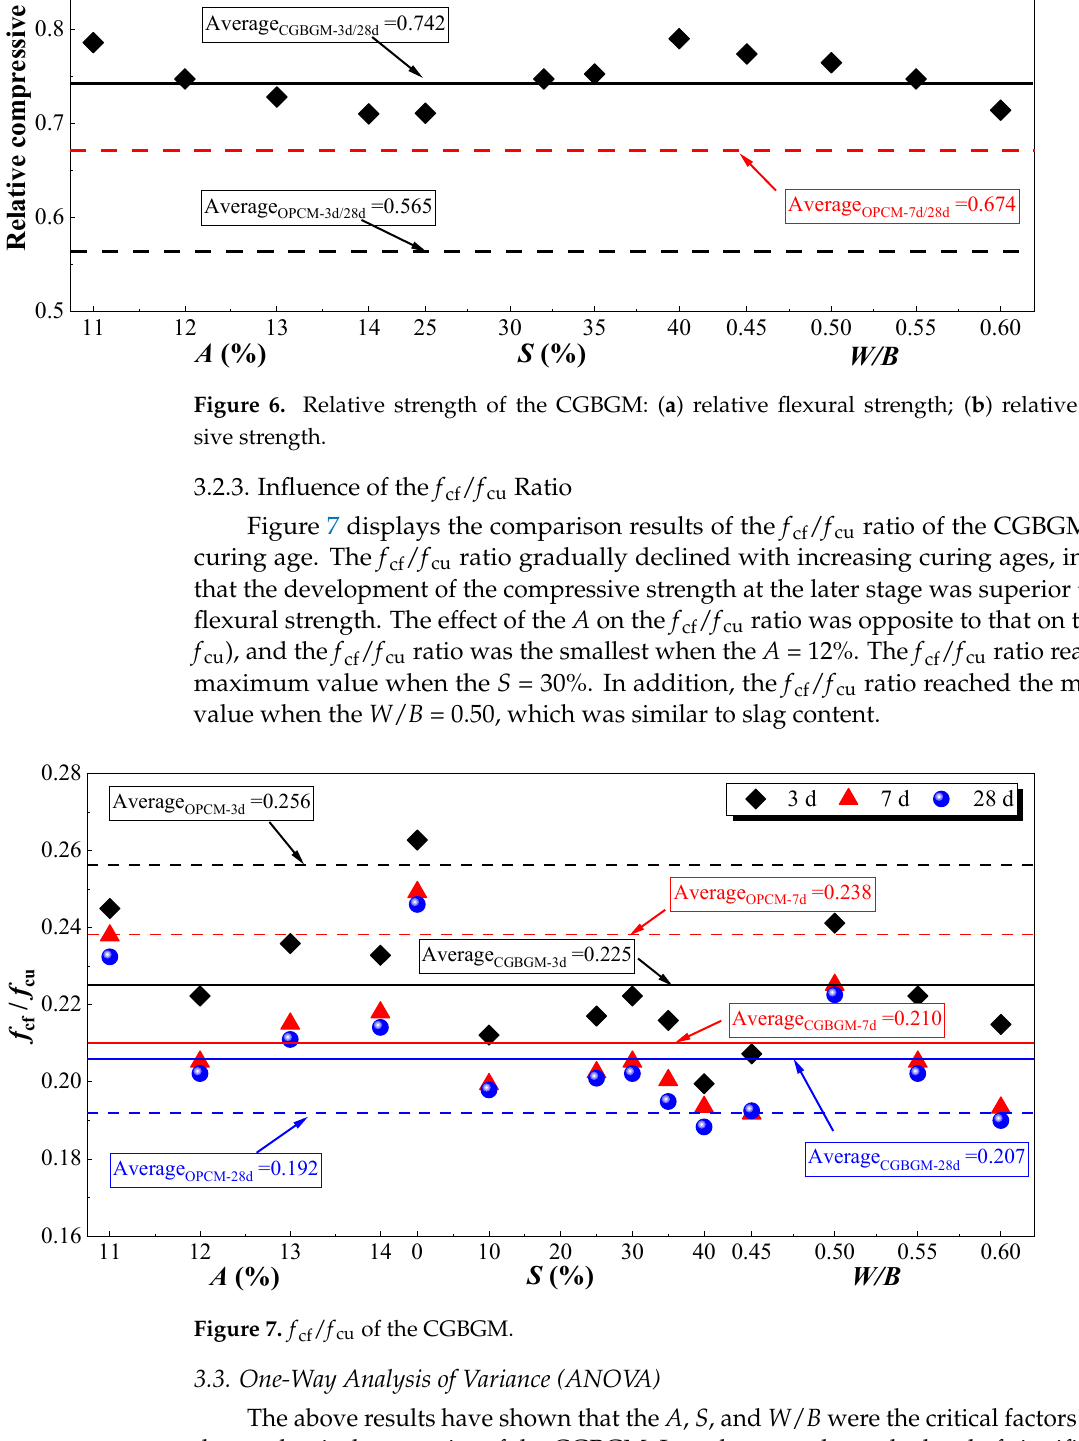
Table 3. Criteria of significant analysis.